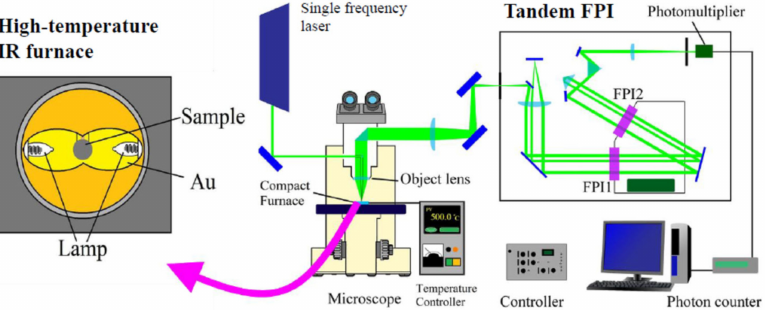
Figure 4. Experimental setup of micro-Brillouin scattering using a tandem multi-pass Fabry-Perot interferometer [48].